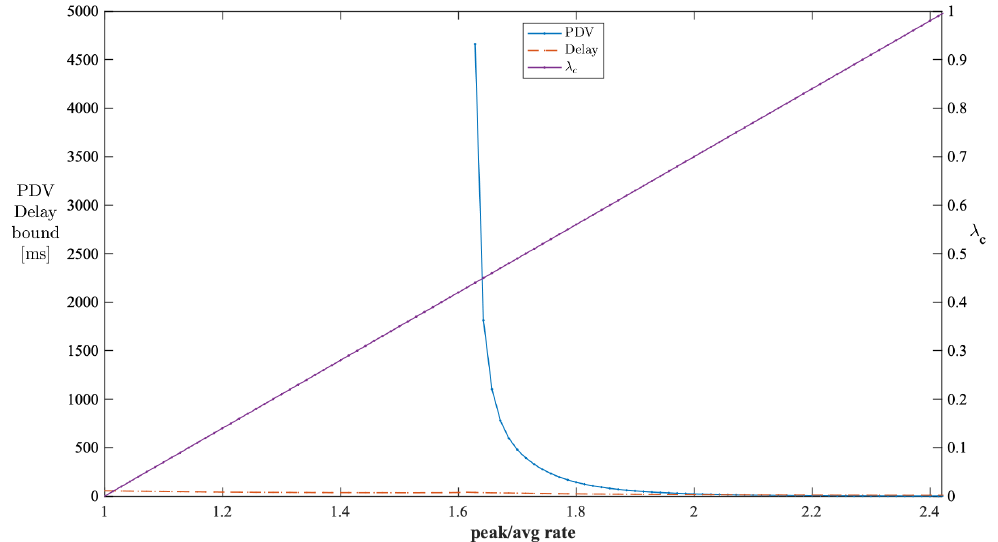
Figure 10. Impact of the peak-to-average rate ratio of cross traffic on the PDV bound in a single-stage network (constant µ c ).